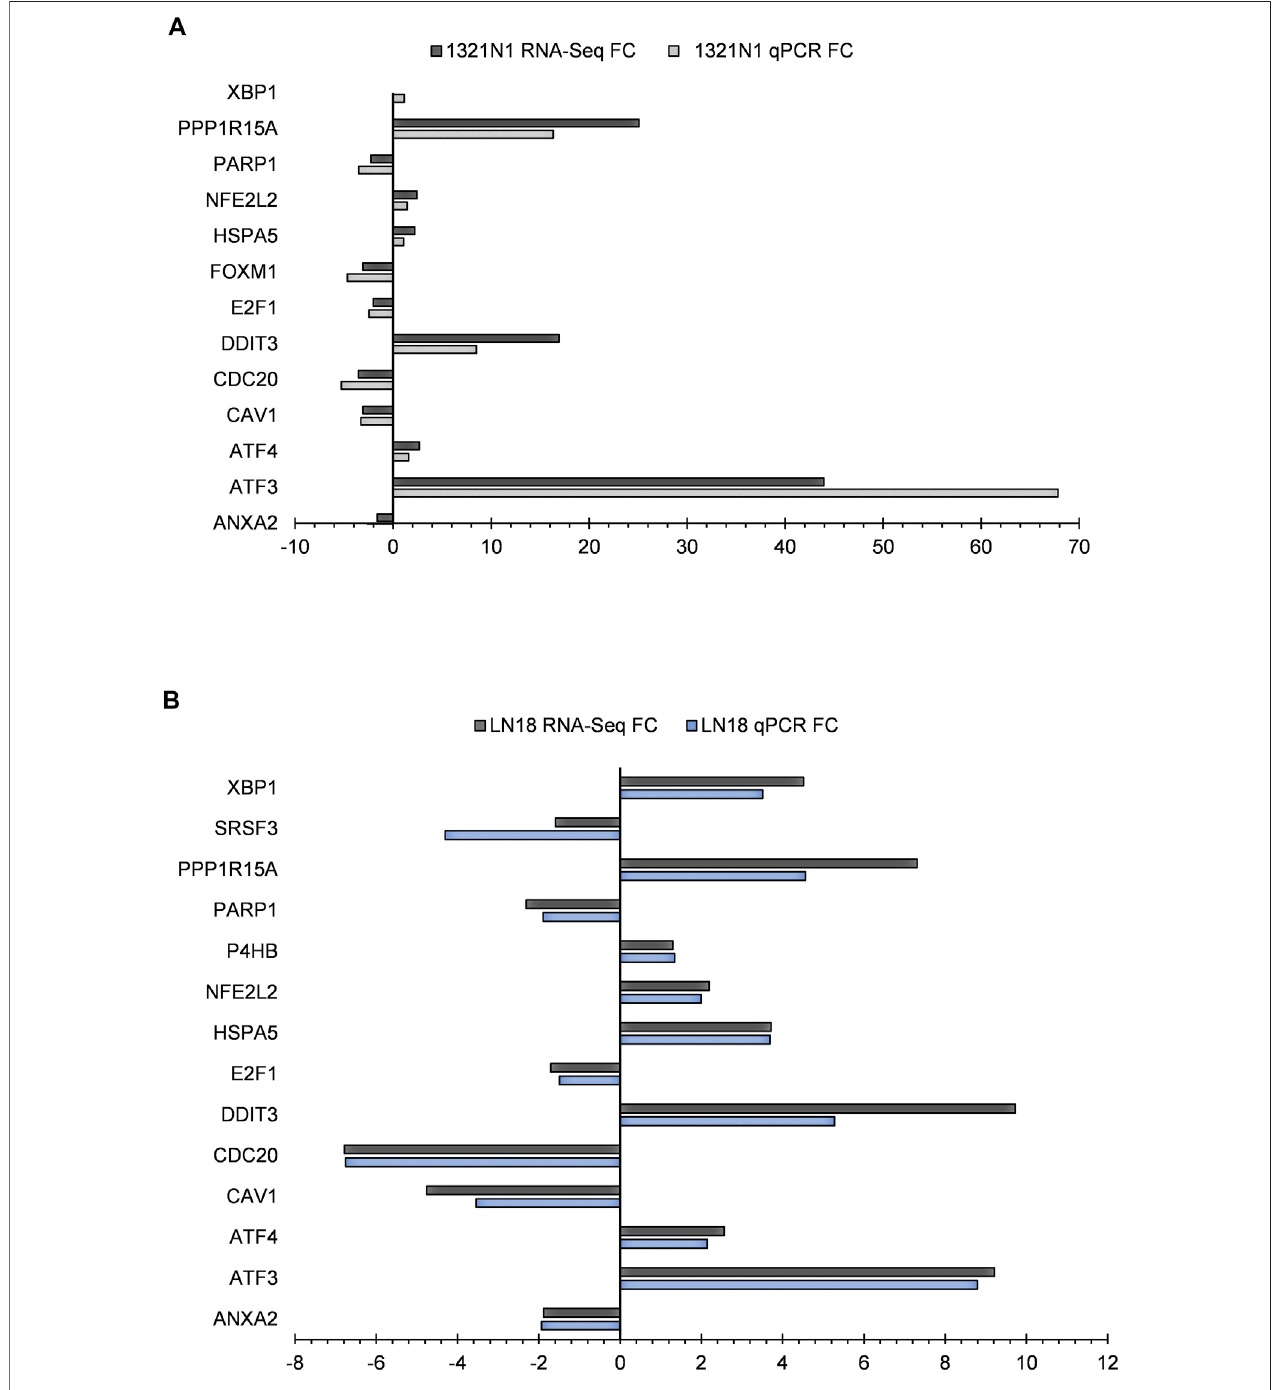
FIGURE 10 | RNA-seq gene expression and genes con fi rmed by qPCR in EGCG+HC treated cells: (A) 1321N1 and (B) LN18.